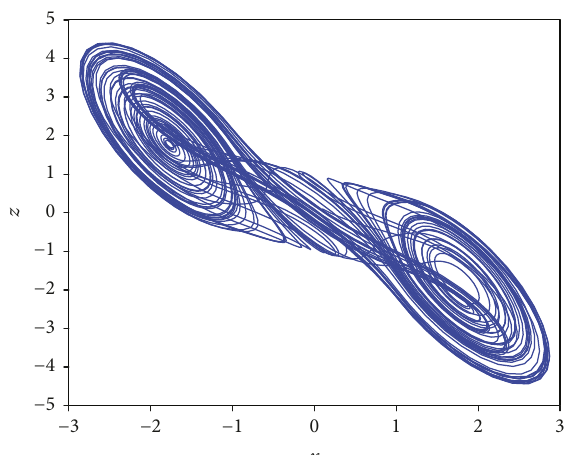
Figure 2: A projection of the double-scroll attractor onto the x , z